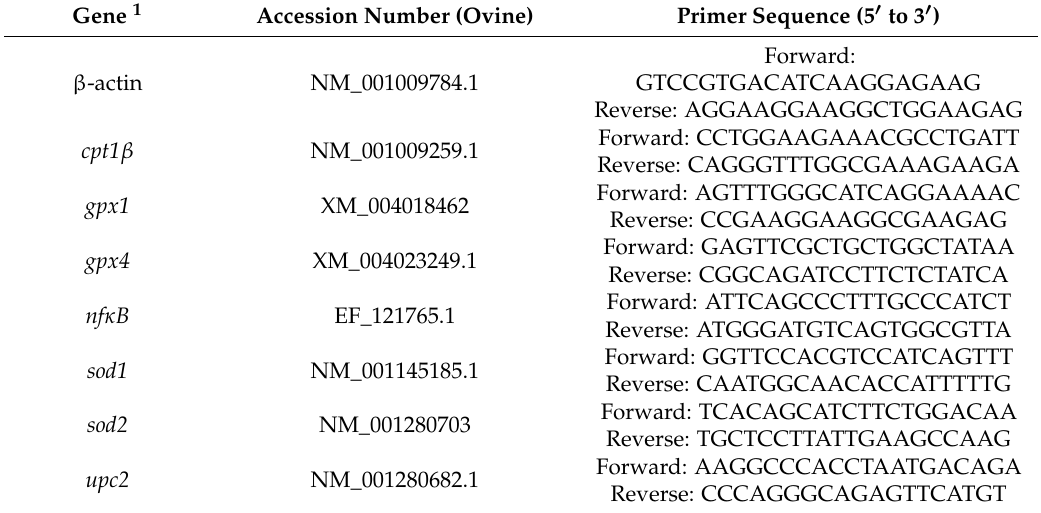
Table 2. Primer sequences used for sheep specific real-time quantitative polymerase chain reaction amplifications utilized for determination of mRNA for target genes in muscle longissimus lumborum (LL)